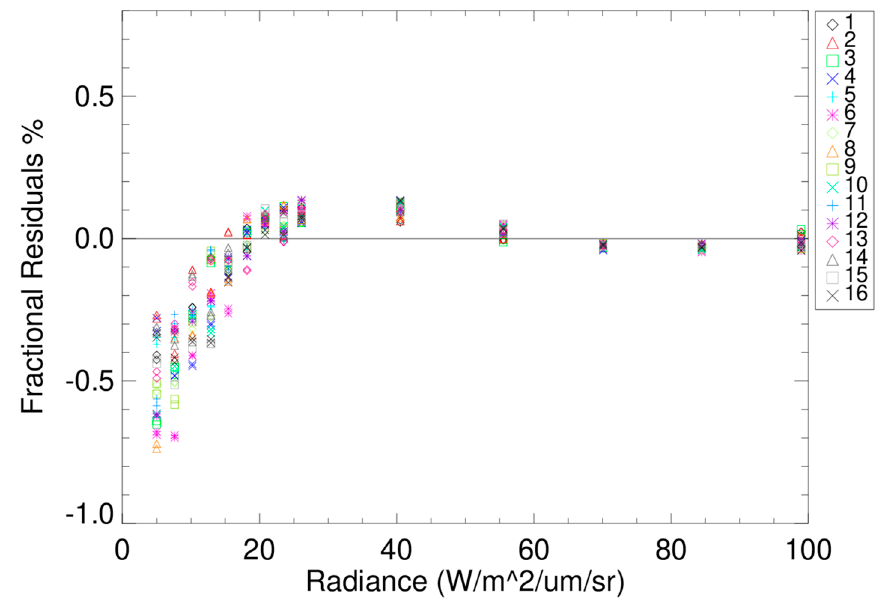
Figure 18. Band M8 fit residuals as a function of SIS100 radiance within the Lmin and Lmax regions for all detectors (colors and symbols) using a third-order polynomial fit.